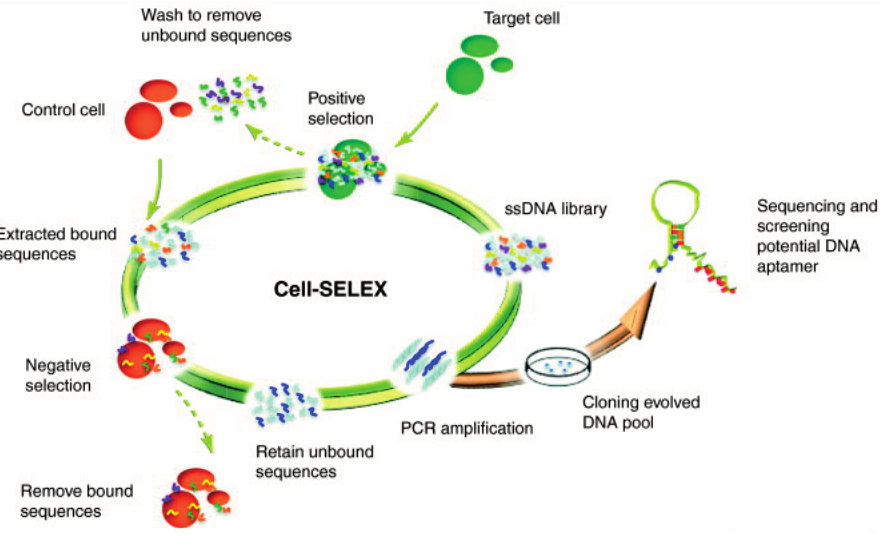
Figure 1. Schematic illustration of the cell-SELEX (systematic evolution of ligands by exponential enrichment) process. Reproduced with permission from Reference